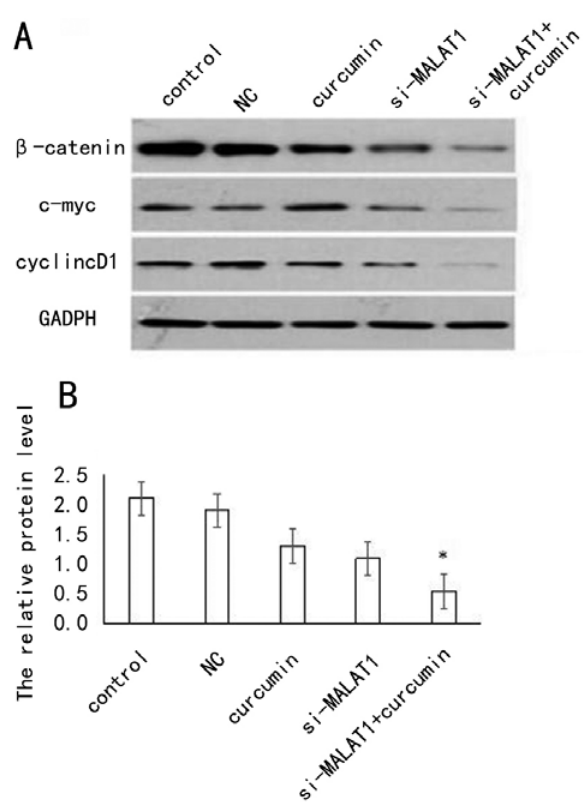
FIGURE 6 - The relative protein expression levels of β-catenin, c-myc and cyclinD1 detected by Western-blotting. A:β-catenin, c-myc and cyclinD1 expression in different treatment groups; B:.The relative protein expression levels of catenin, c-myc and cyclinD1 in different treatment groups, Mean ± SD. n =3 .* P <0.05 vs other